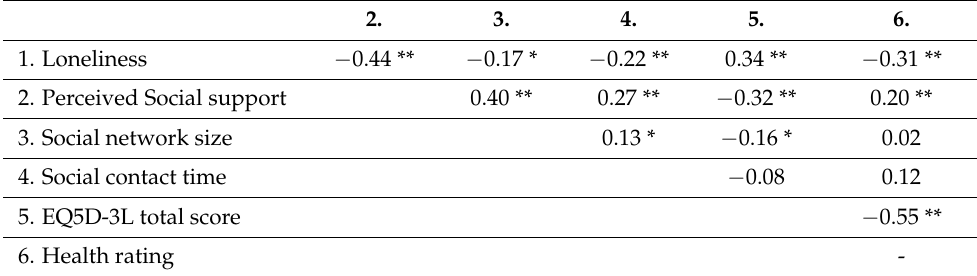
Table 4. Unadjusted Pearson’s correlations between loneliness, social variables, and